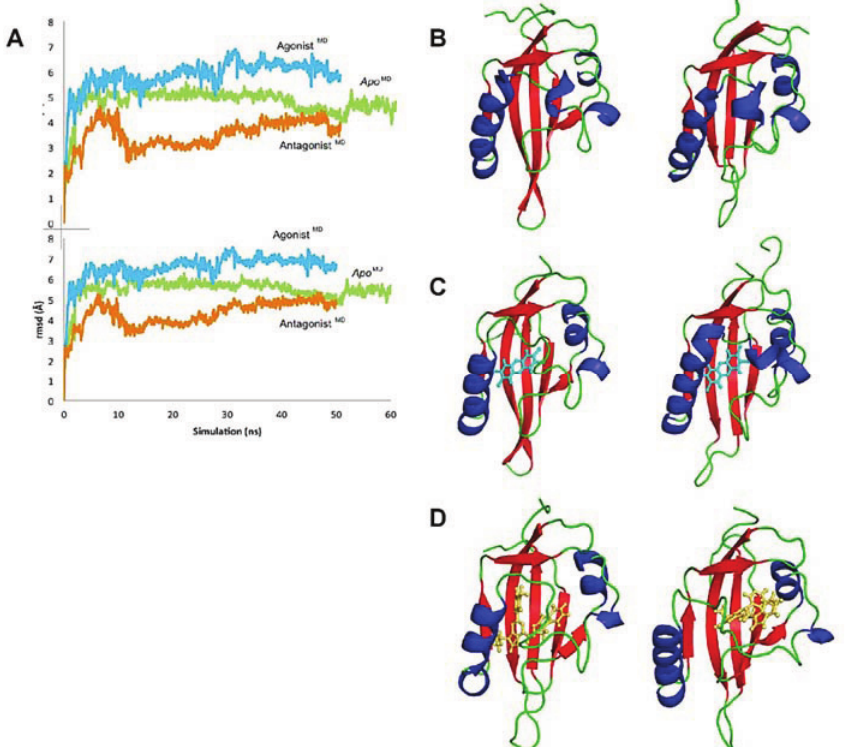
Figure 9. Evolution of the AHR PAS-B structures over time. ( A ) The rmsd at every 100 frames is shown for the backbone atoms of apo (green), agonist-bound (cyan), and antagonist-bound (orange) simulations in the top panel; the rmsd for all protein atoms is shown in the lower panel. The equilibrated agonist MD model deviates from the equilibrated apo MD by 0.9 Å (69 C(cid:2) atoms) and from the HIF-2(cid:2) PAS-B structure by 1.1 Å (68 C(cid:2) atoms), and the equilibrated antagonist MD model deviates from the apo MD by 1.1 Å (55 C(cid:2) atoms) and 1.2 Å (61 C(cid:2) atoms) from HIF-2(cid:2). ( b – d ) Conformation changes during the course of simulation are shown. The structure at 0 ns is shown left and at the end of the simulation is shown right for apo ( B ), agonist-bound ( C ), and antagonist-bound ( D ) simulations. The models are colored by secondary structure: helices, blue; strands, red; loops, green and the ligands are shown as cyan sticks (TCDD) or orange sticks